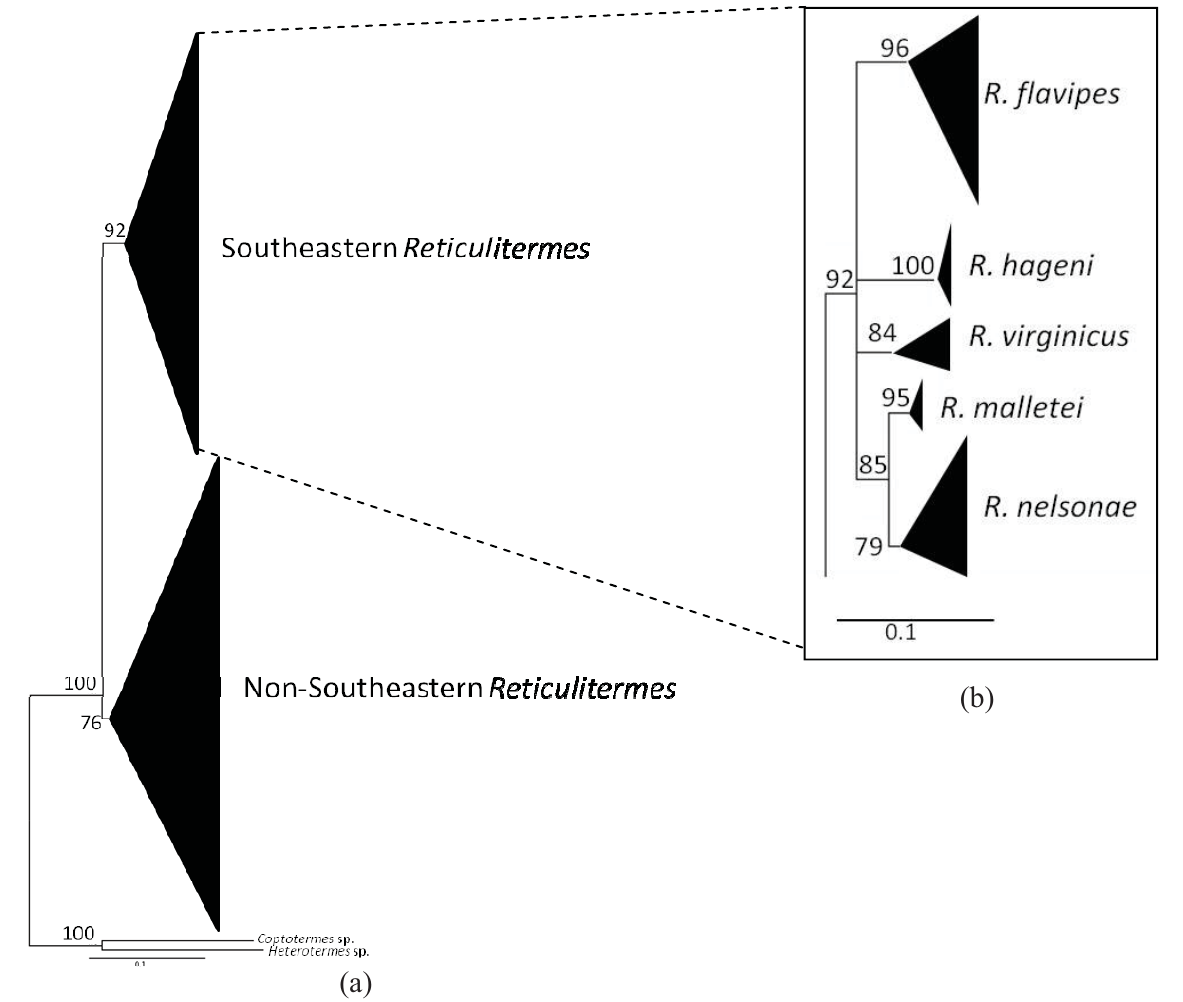
Figure 4. Maximum Likehood (ML) estimate of the Reticulitermes phylogeny based on mitochondrial cytochrome oxidase II (COII) gene data (665 bp). The scale bar represents 0.1 substitution/ site. ( a ) Collapsed tree topology illustrating the branch support and clades formed by Reticulitermes species from the southeastern USA and other regions of the world. ( b ) Collapsed tree topology illustrating the branch support and clades formed by Reticulitermes from southeastern